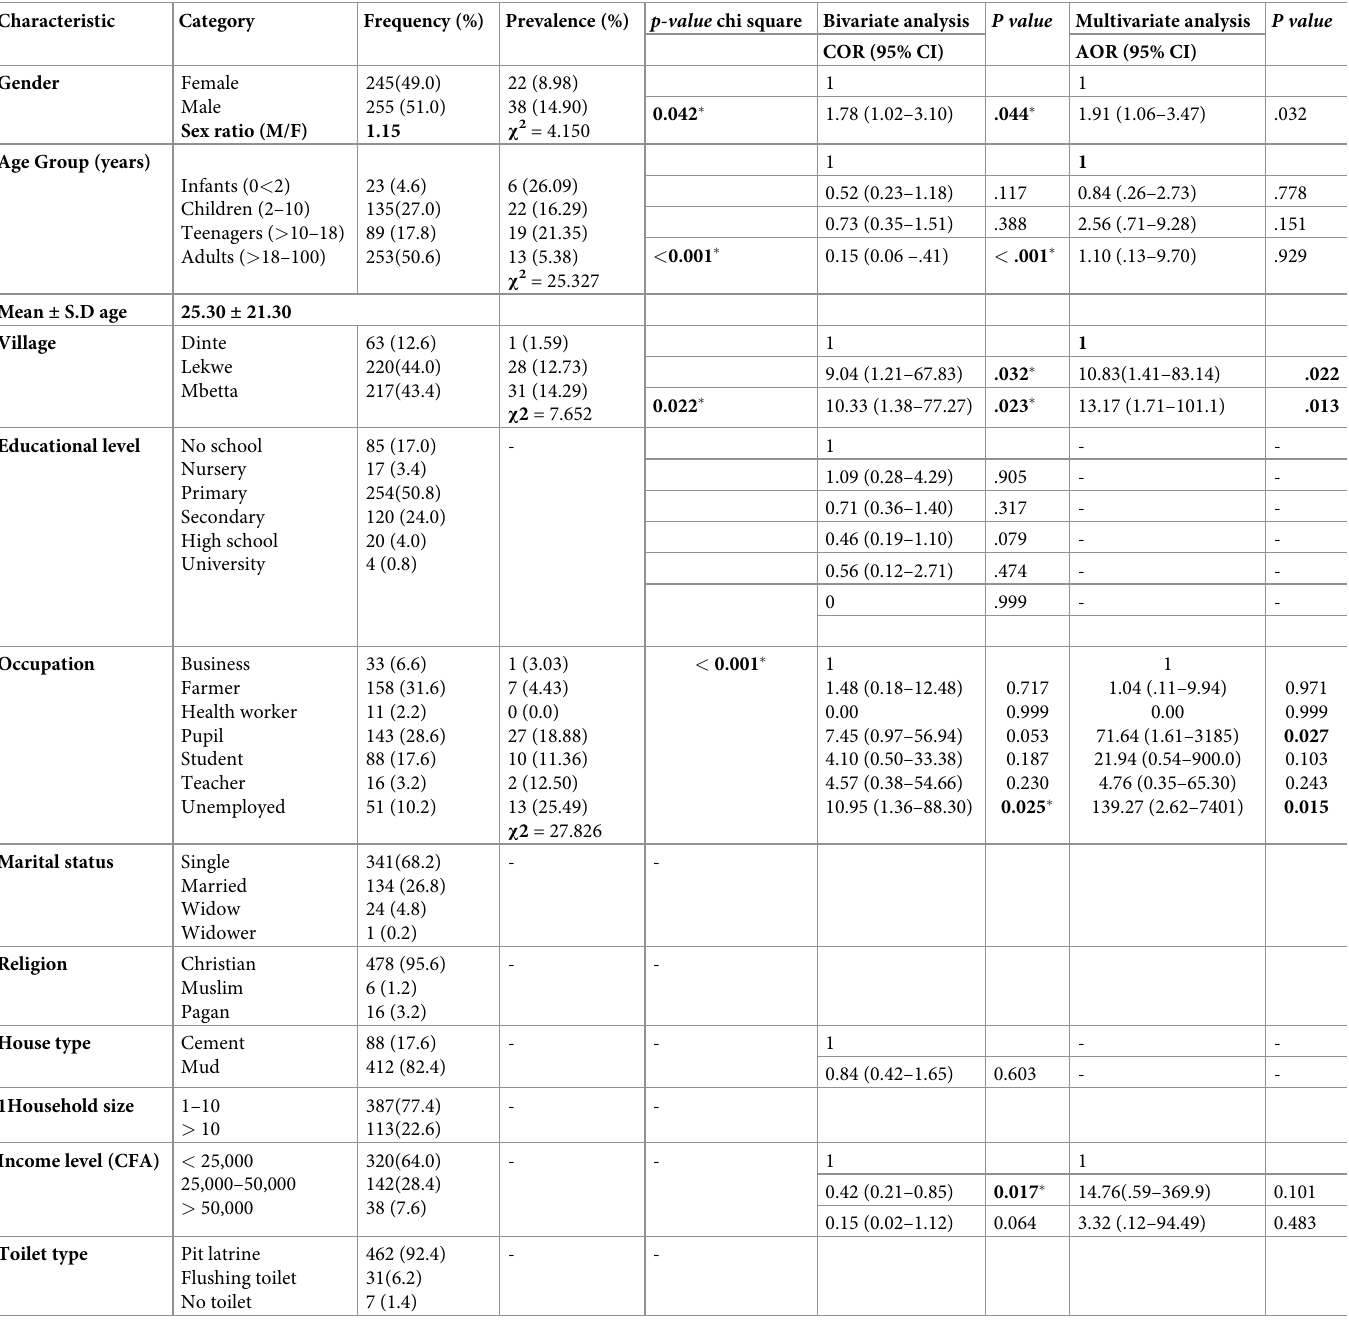
S.D = Standard Deviation M/F ratio = Male to Female ratio COR: Crude Odds Ratio AOR: Adjusted Odds Ratio. � Statistically significant association, p < 0.05 χ 2 = Pearson’s Chi square